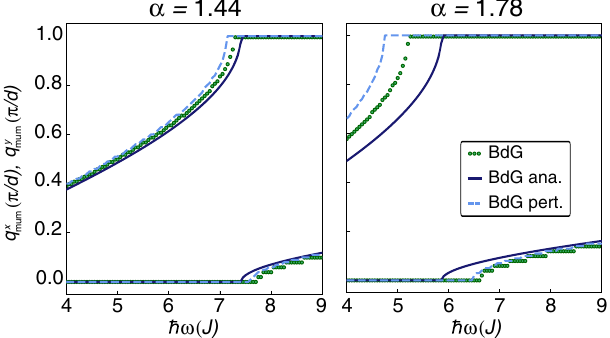
FIG. 5. Comparison of the perturbative analytic treatment calculated to zeroth [solid blue line, Eqs. (3) and (4)] and second order (dashed blue line) with numerical simulations of the exact BdG equations (green dots) for g=J ¼ 11 . 5 and two modulation amplitudes, α ¼ 1 . 44 (left) and α ¼ 1 . 78 (right). The steps in the numerical results are due to the discretization in momentum